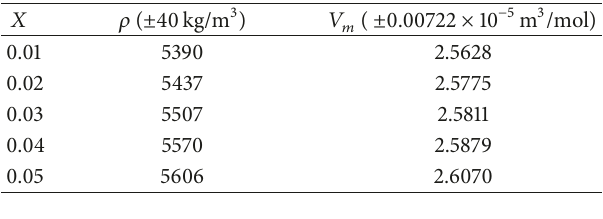
Shear velocity Figure 5: Ultrasonic velocities of [(TeO 2 ) 0.70 (ZnO) 0.30 ] (1−𝑥) (Nd 2 O 3 NPs) (𝑥) glasses